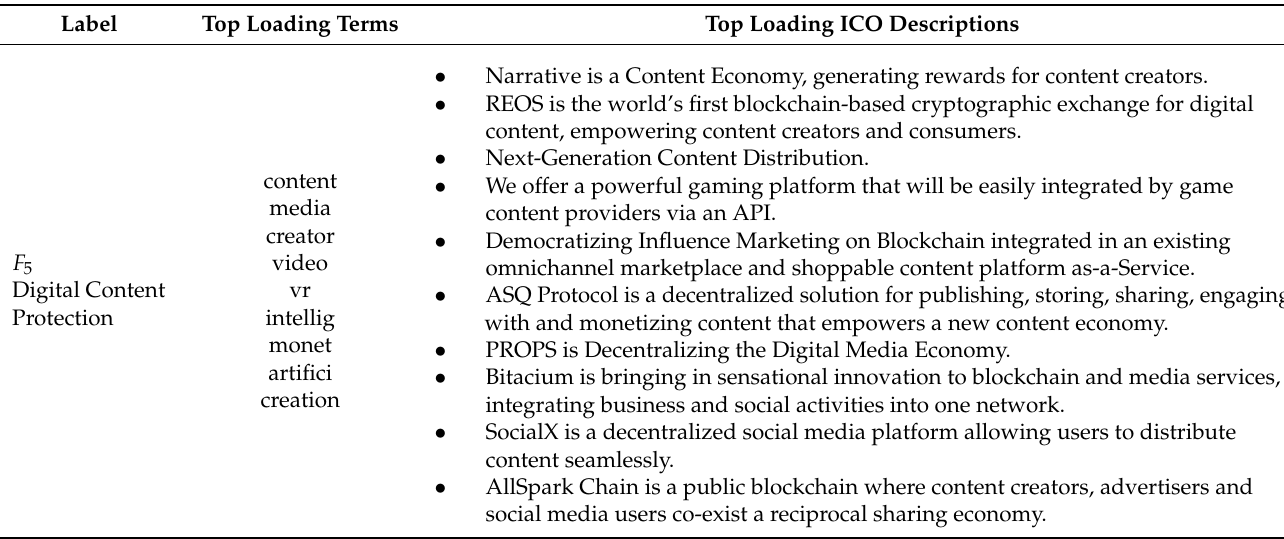
Table A5. Digital Content